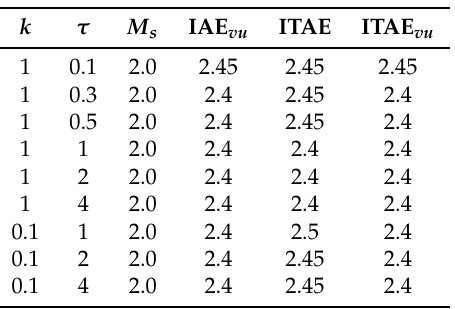
, with varying gain velocity, s M s , i.e., the minimum of the M s , ¯ c